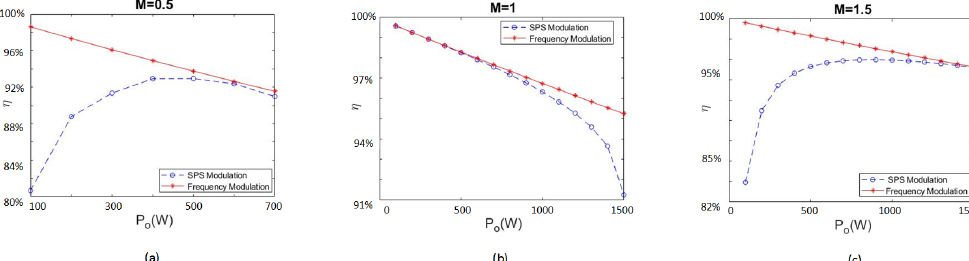
Figure 17. Comparison of the power losses between the SPS modulation and frequency modulation schemes for ( a ) M = 0.5, ( b ) M = 1, and ( c ) M = 1.5.